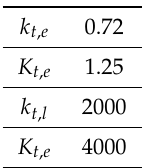
Table 6. Relationship parameters between different types of cost.